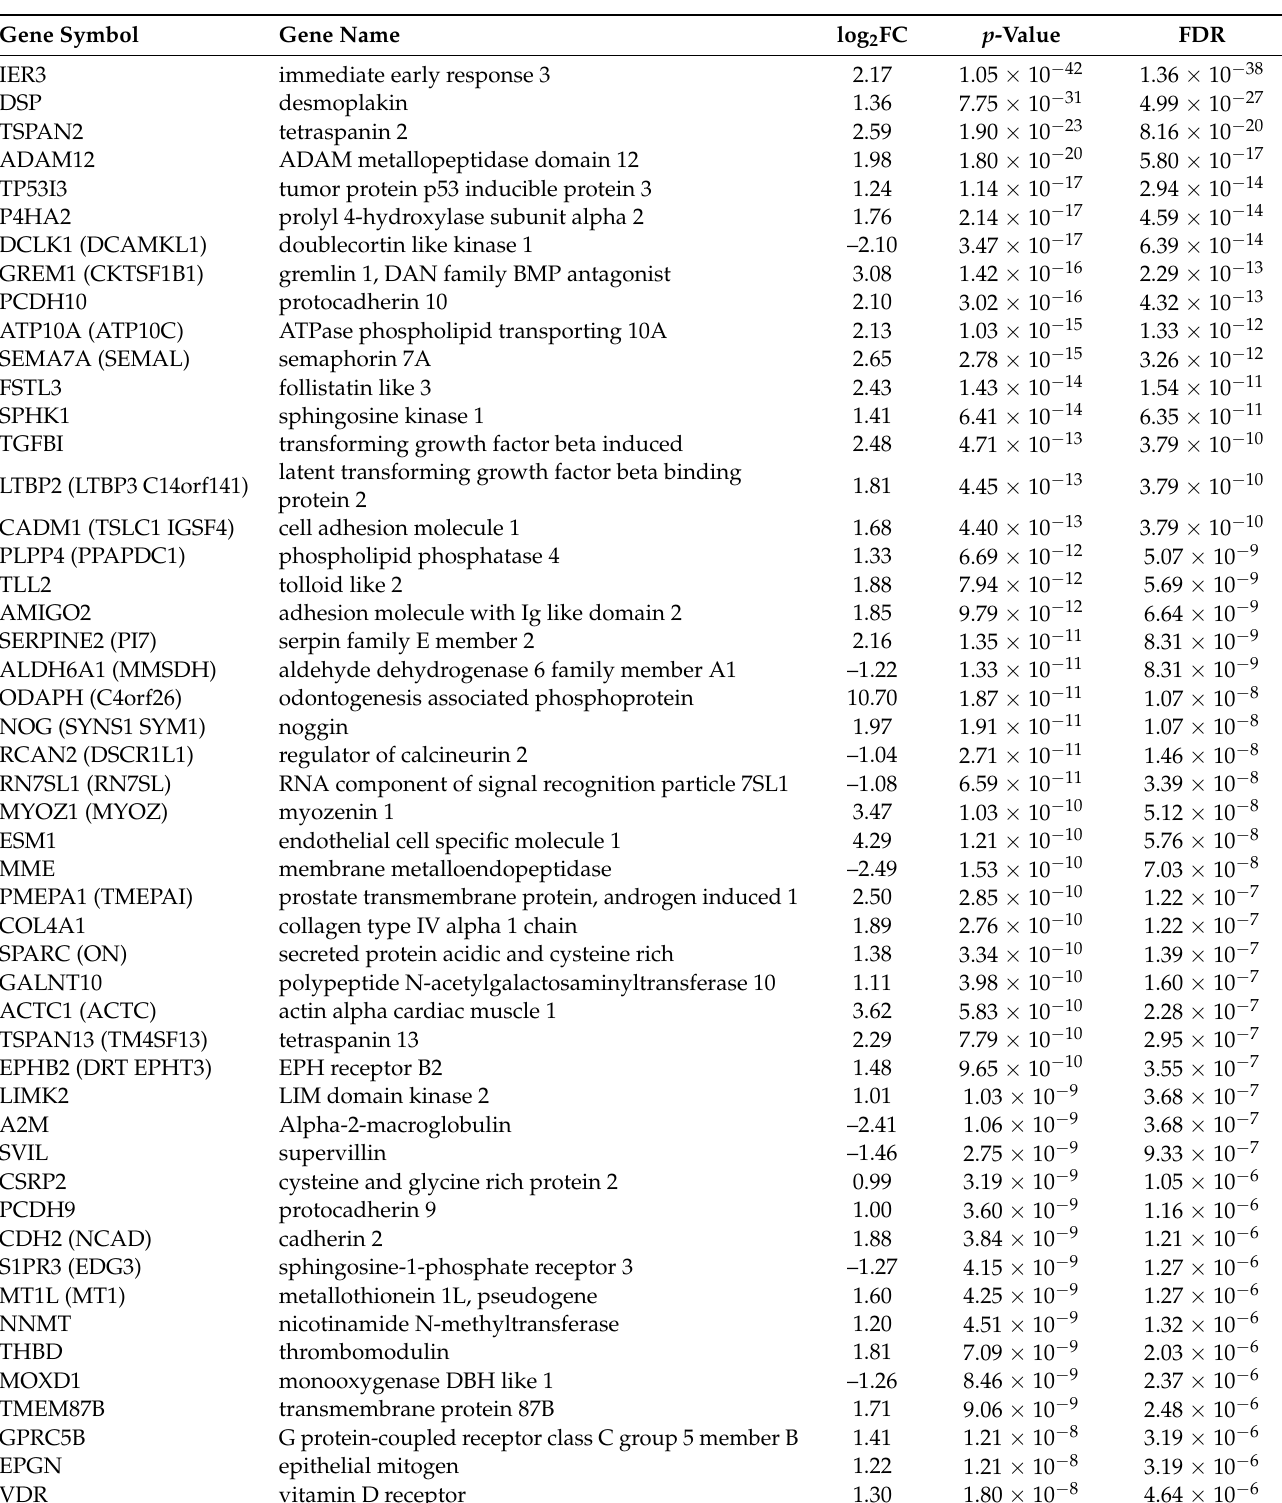
Table 1. Top 50 differentially expressed genes, ranked by false discovery rate (FDR). For each gene the current and previously used symbols, name, log 2 FC (binary logarithm of fold change), p -value and adjusted p -value in the form of false discovery rate (FDR) are